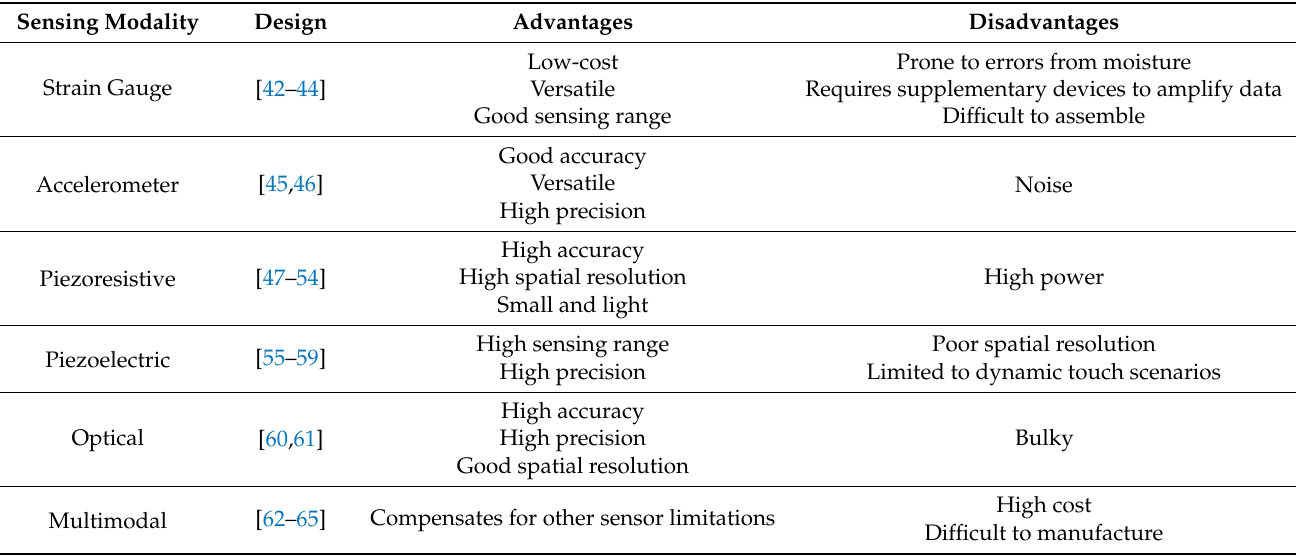
Table 1. Comparative study of various actuators used for touch